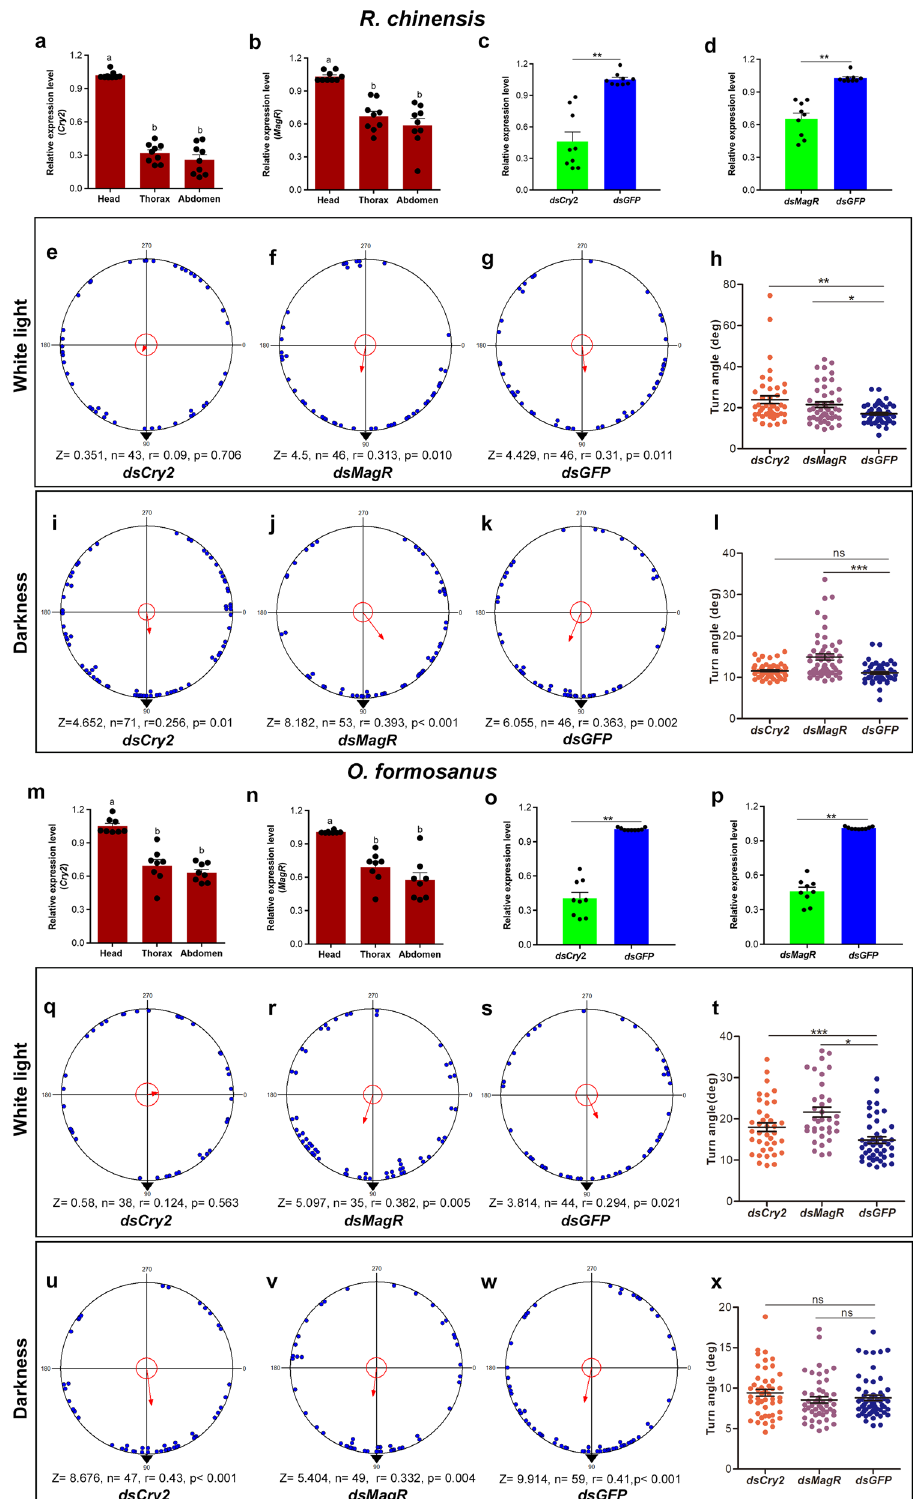
resulted in a signi fi cant increase in the turn angle as compared to However, the termites injected with ds Cry 2 exhibited direc- control termites (Mann – Whitney test, R. chinensis : Z = − 3.15 , tional preference in complete darkness (Rayleigh test, R. df = 88 , p < 0.05; O. formosanus : Z = − 2.43, df = 81, p < 0.05) chinensis : r = 0.256, p = 0.01; O. formosanus : r = 0.43, p < 0.001) (Fig. 3h, t). In addition, the injection of ds MagR signi fi cantly (Fig. 3i and u), and the termites injected with ds MagR or ds GFP increased the walking turn angle compared with the control also exhibited directional preference (Rayleigh test, R. chinensis : (Mann – Whitney test, R. chinensis : Z = − 2.00, df = 90, p < 0.05; ds MagR , r = 0.393, p < 0.001, dsGFP , r = 0.363, p = 0.002; O. formosanus : ds MagR , r = 0.332, p = 0.004, ds GFP , r = 0.41, O. formosanus : Z = − 4.41, df = 77, p < 0.001) (Fig. 3h, t). COMMUNICATIONS BIOLOGY| (2021) 4:1121 |https://doi.org/10.1038/s42003-021-02661-6|www.nature.com/commsbio